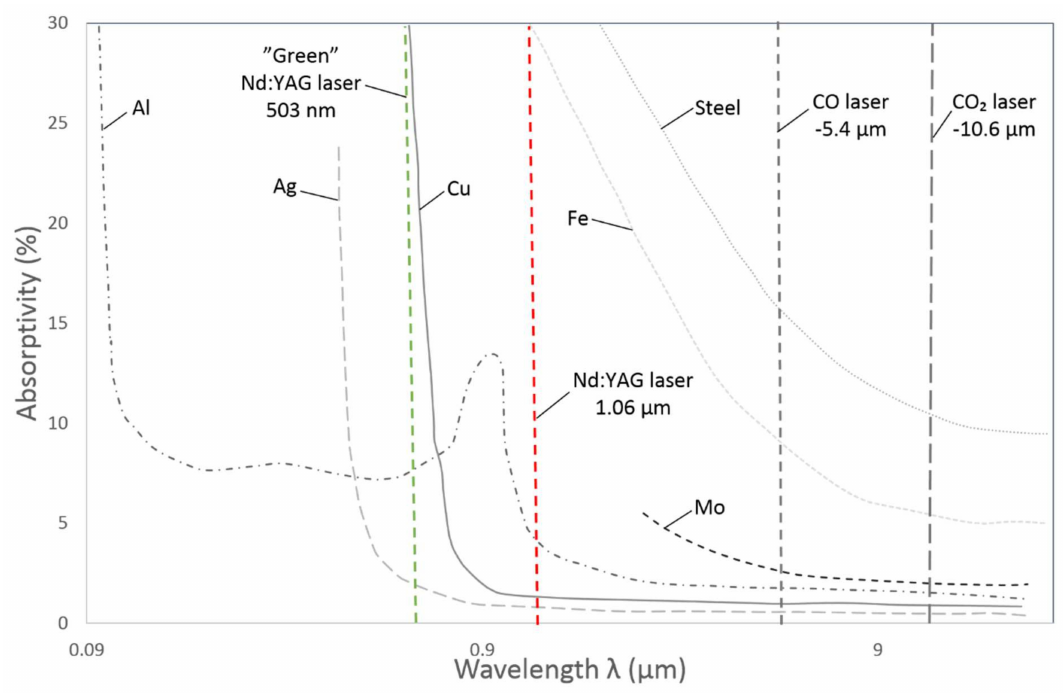
Figure 10. Absorptivity for different materials. The wavelength of different types of laser are shown in the vertical dash lined intercept